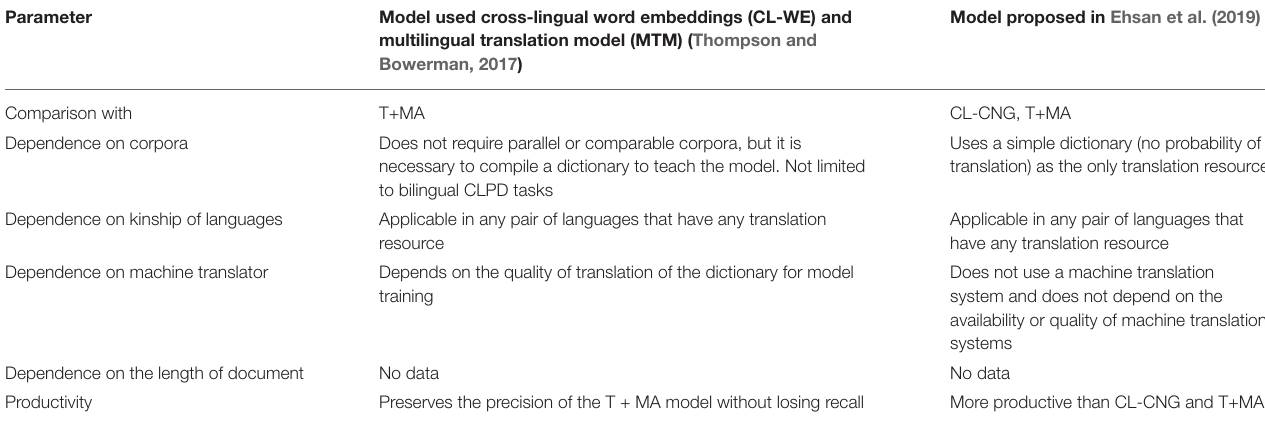
TABLE 3 | Comparative table of model used cross-lingual word embeddings (CL-WE) and multilingual translation model (MTM) (Thompson and Bowerman, 2017) and model proposed in Ehsan et al. (2019).